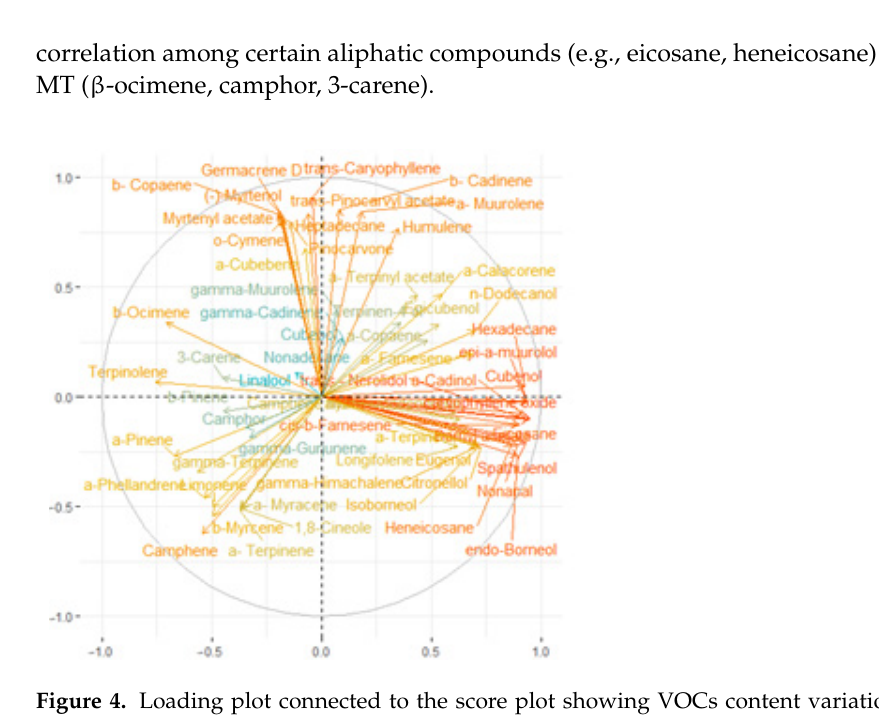
( c ) Figure 6. PCA loading plot performed on the BVOCs content in the genotypes of the examined species: ( a ) Austrian pine, ( b ) Scots pine, ( c ) Spruce.